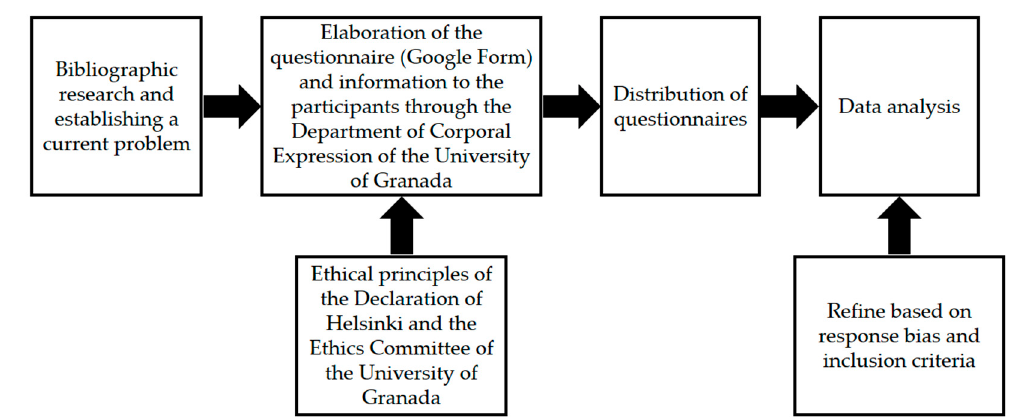
Figure 1. Study procedure.